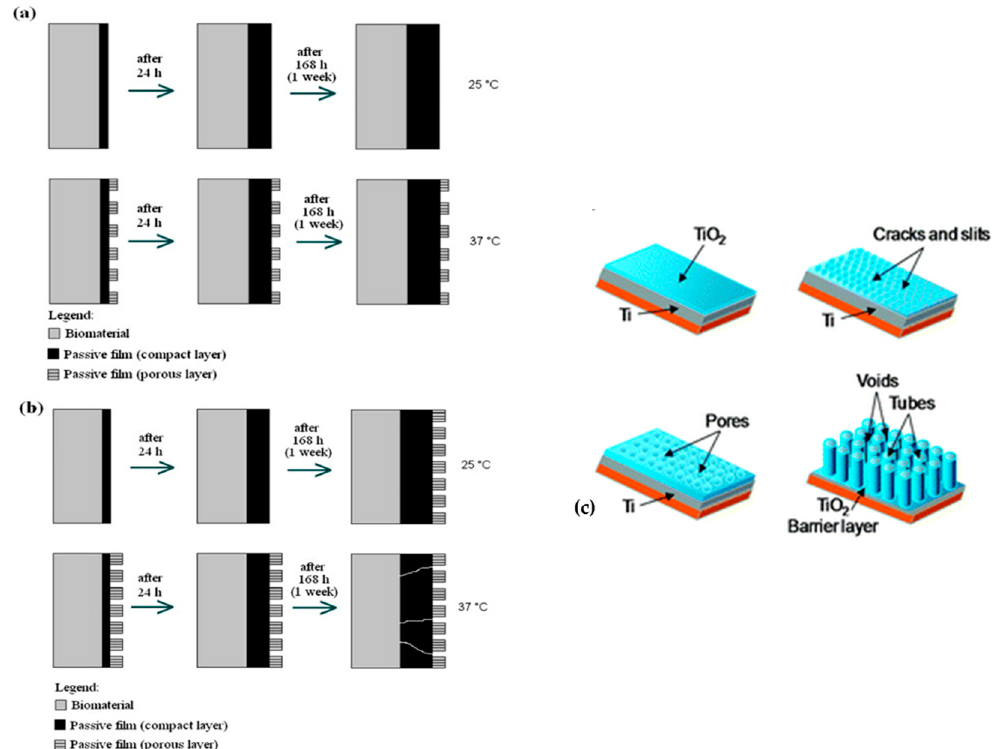
Figure 9. ( a , b ) Scheme showing the effect of solution temperature and time of immersion in SBF on the formation of a passive layer on ( a ) Ti and ( b ) Ti–6Al–4V alloy. Reprinted from [117], copyright (2009), with permission from Elsevier. ( c ) Growth of a nanotubes array on titanium metal. Republished with permission of Royal Society of Chemistry from [120]; permission conveyed through Copyright Clearance Center, Inc. Improved Figure.